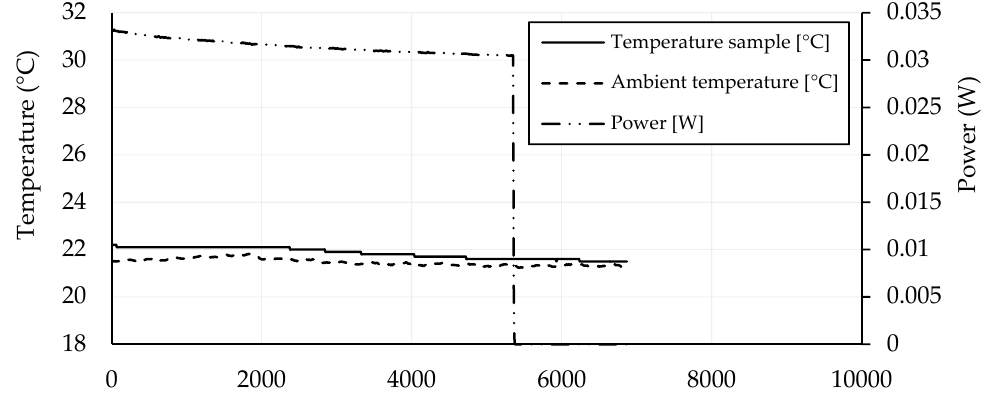
Figure 6. Self-heating experiment—CB 1.25, 100 V.